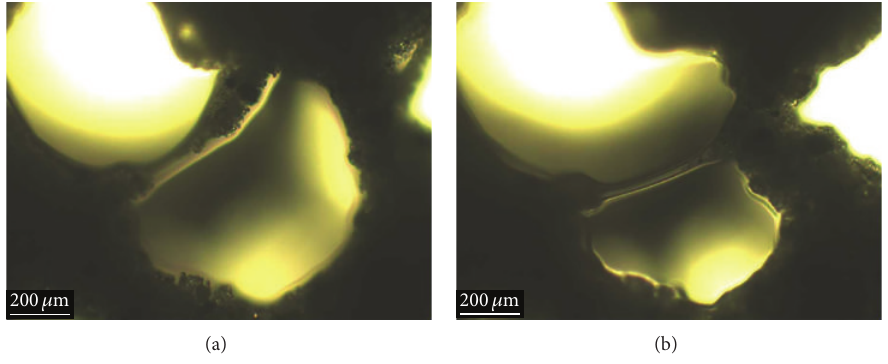
Figure 9: The bursting process of an unstable bubble.